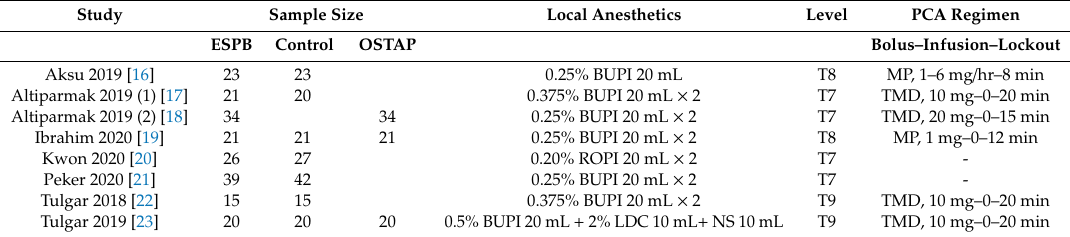
Table 1. Baseline characteristics of the included randomized controlled trials (RCTs) (n =